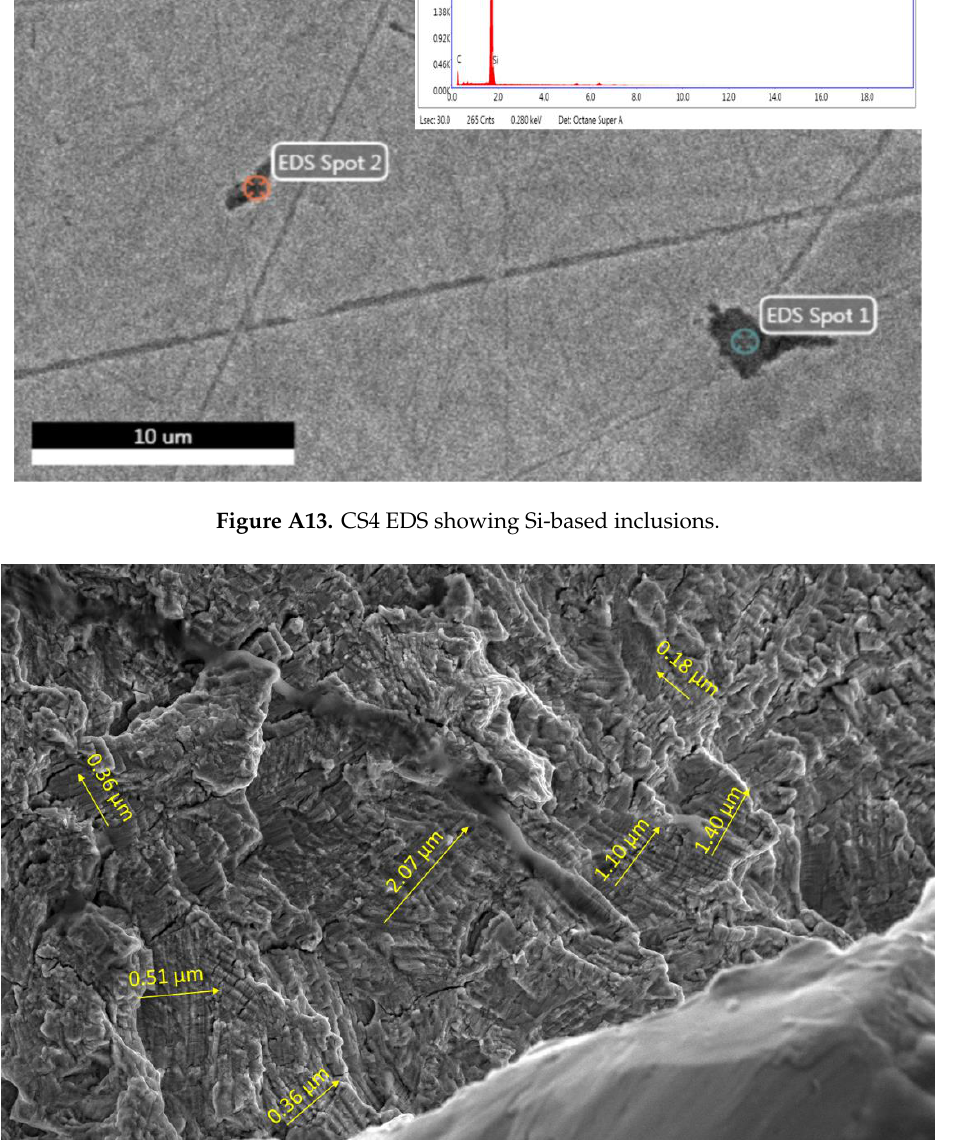
Figure A14. Counting the average striation spacing on the surface of the CS1 screw shows that the crack propagated from the bottom left to the top right.